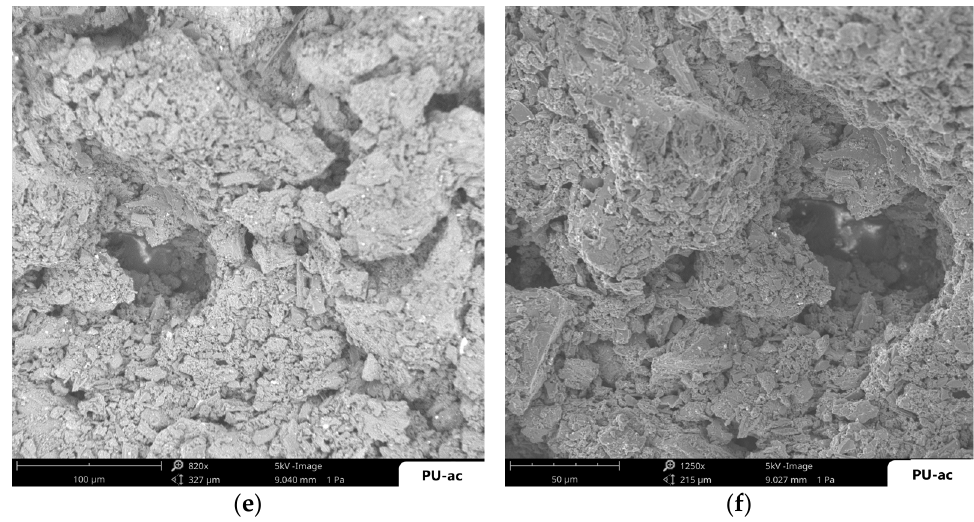
Figure 3. ( a , b ) SEM images of the starting polyurethane 1 at different magnifications; ( c , d ) SEM images of the polyurethane composite PU-Si 2 at different magnifications. ( e , f ) SEM images of the polyurethane composite PU-ac 3 at different magnifications.